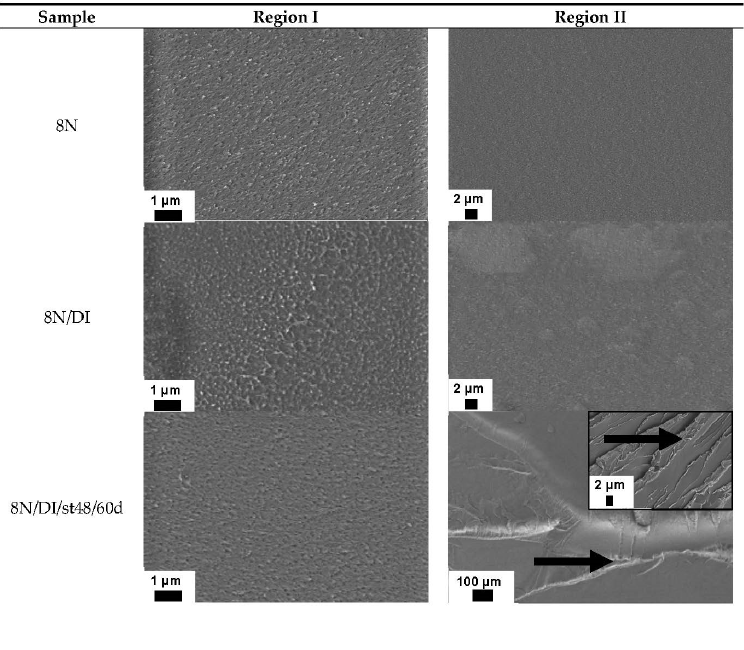
Figure 6. Comparisons of the fracture surfaces of the 8N samples after in situ wetting and prior immersion via SEM images of region I and II (marked in Figure 5).